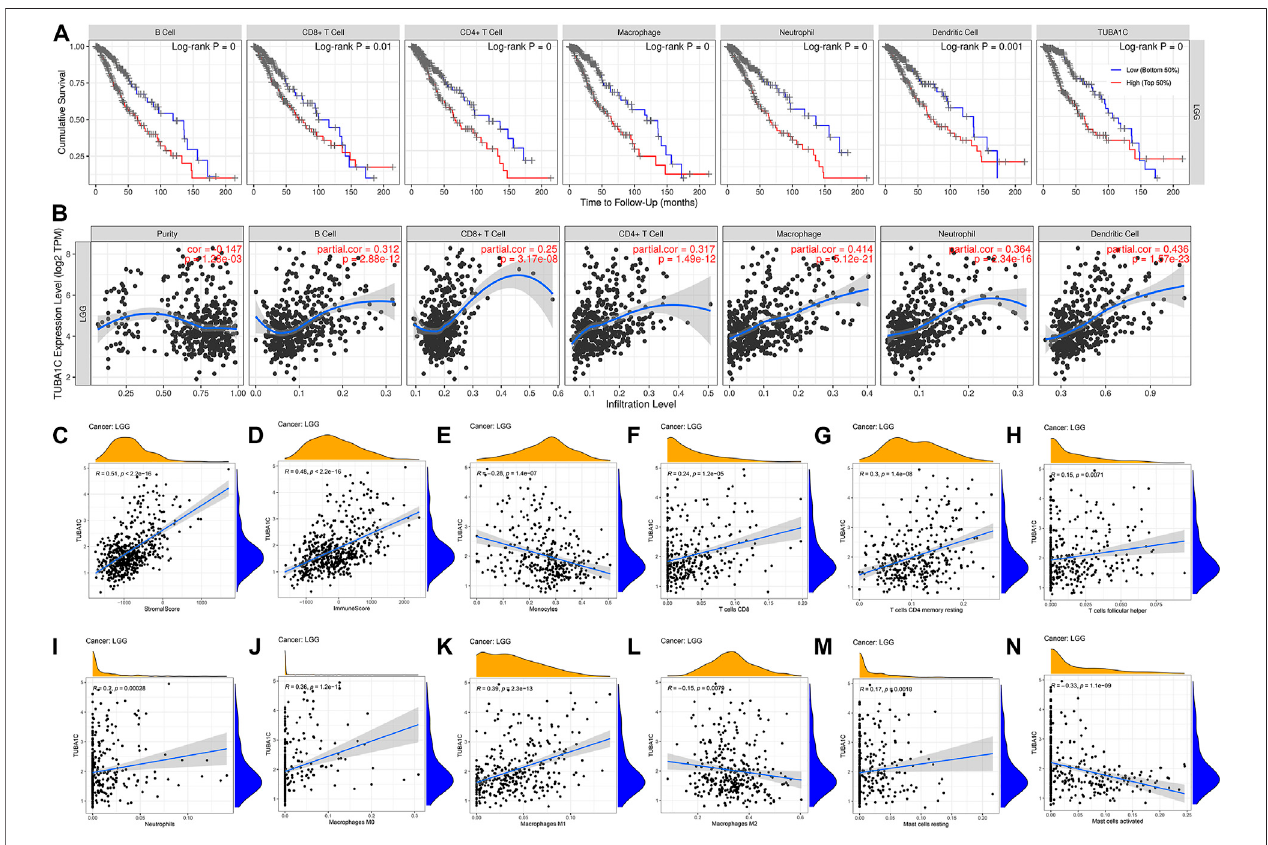
FIGURE4| ThecorrelationsbetweenTUBA1Cexpressionandimmunecellin fi ltrationinthetumormicroenvironment. (A) Correlationofin fi ltratinglevelsofimmune cells with the cumulative survival of LGG. (B , E – N) Relationships between TUBA1C expression levels and immune cell in fi ltration in LGG. (C) Correlation of TUBA1C expressionandstromalscore. (D)